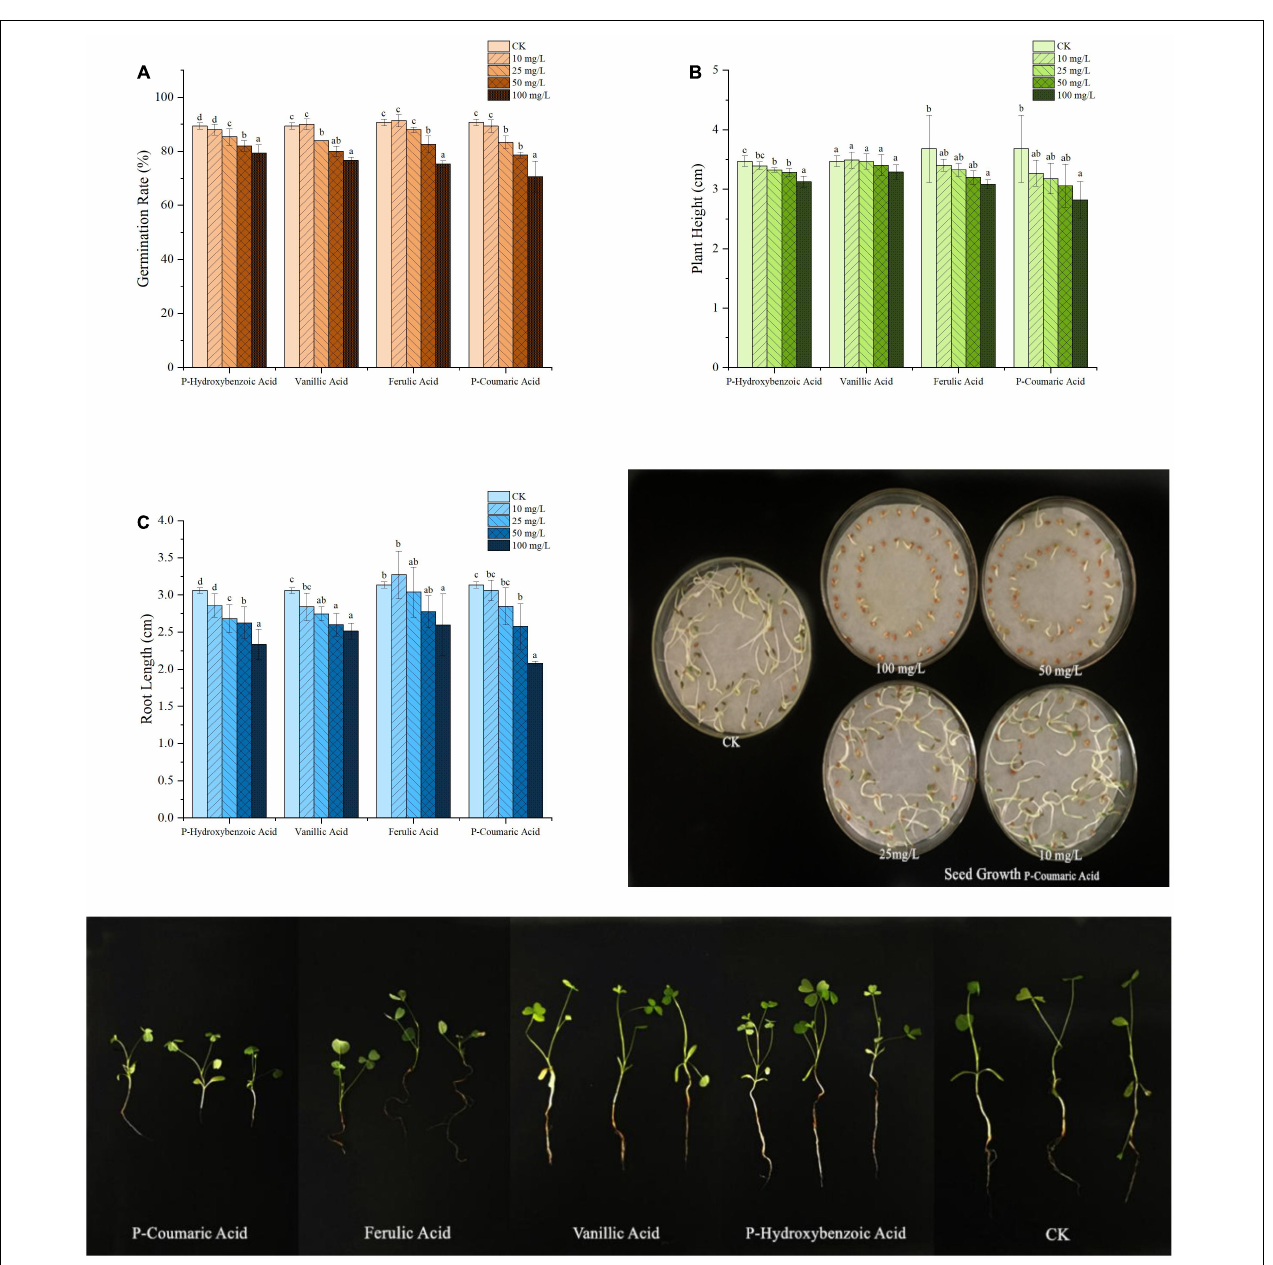
FIGURE 4 | Effect of different concentrations of phenolic acids on alfalfa germination rate (A) , plant height (B) , and root length (C) . Error bars indicate standard errors of the means of three repetitions. Different letters above the bars indicate significant difference according to Duncan’s multiple range test (P = 0.05).